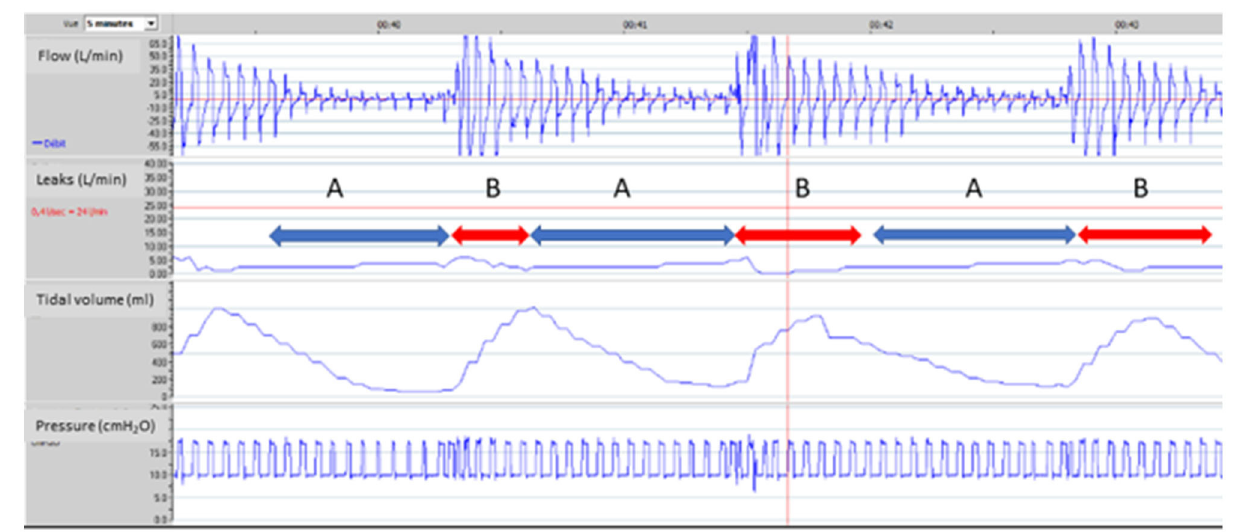
FIGURE 3 | Upper airway obstruction under NIV. 65-year-old male subject, obesity-hypoventilation with obstructive sleep apnea syndrome (OSAS). Bi-level pressure support ventilator, ResScan software, ResMed. Facial mask. Ventilator settings: ST Mode (spontaneous/timed), IPAP (Inspiratory positive airway pressure): 20 cmH 2 O; EPAP (Expiratory positive airway pressure): 10 cmH 2 O; BURR (Back-up respiratory rate): 16 cycles/min. From top to bottom: flow, unintentional leaks (i.e.: difference between total leak flow and estimated flow through the leak valve of the mask), tidal volume, pressure. 5 min window. Red line on leaks tracing (24L/min) is a